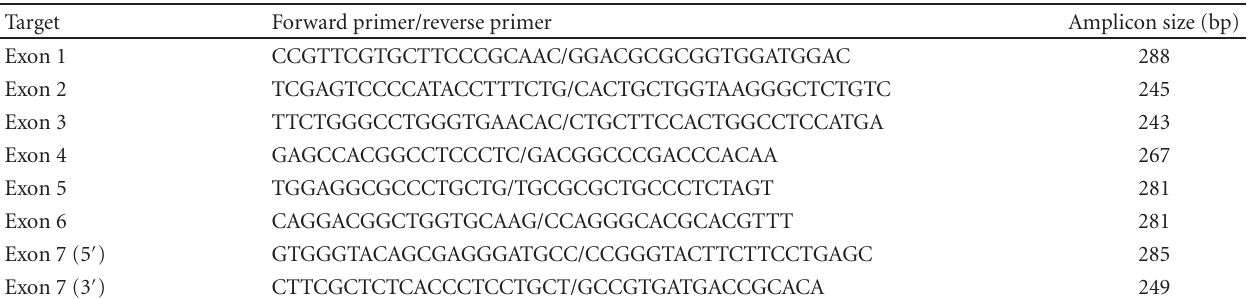
Table 1: PCR primer sequences used for analysis of canine the CLN6